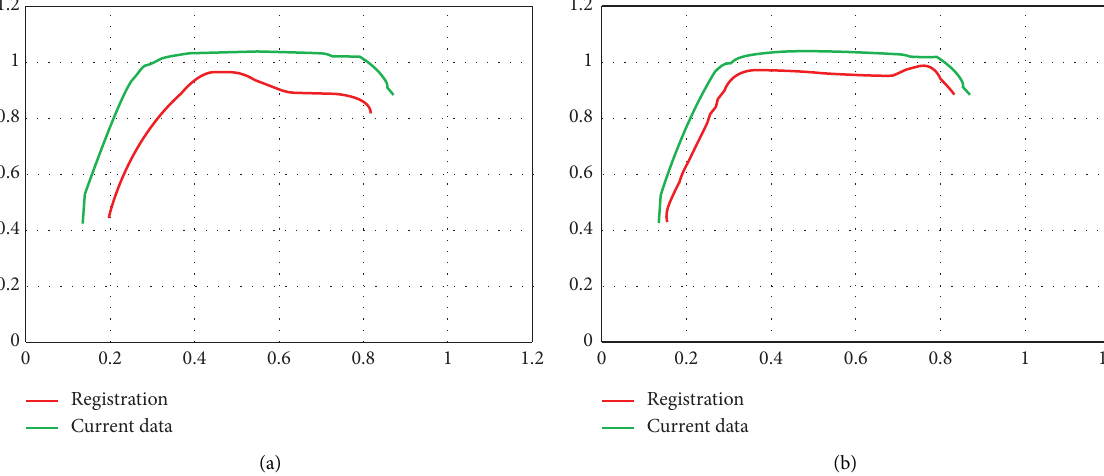
Figure 11: ICP experimental results based on line segment features (group I). (a) Common ICP methods. (b) Line based ICP methods.